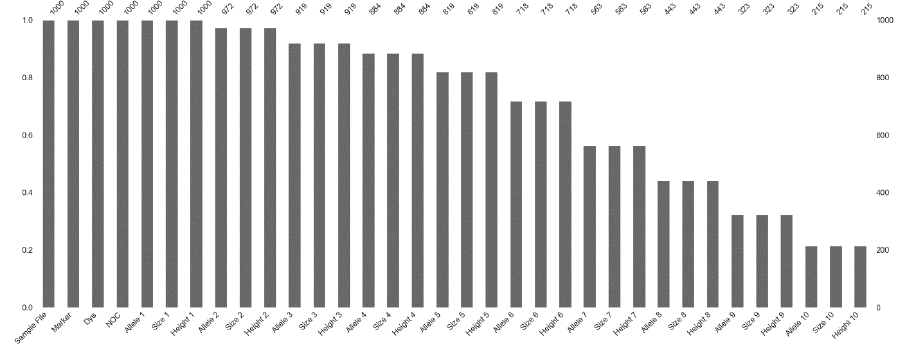
Figure 18. The resultant dataset. Table 3. The markers for the four